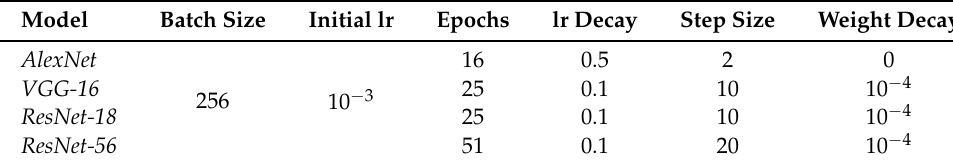
Table 1. Details of the fine-tuning of the